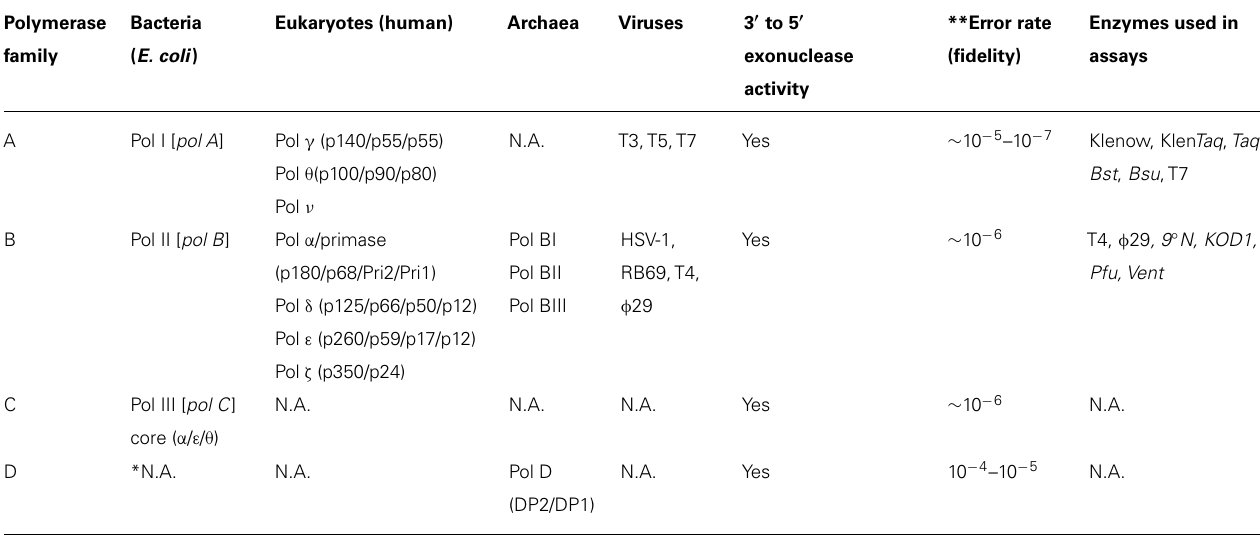
Table 1 | Families and properties of cellular DNA replicases (Kunkel, 2004; Hübscher etal., 2010; Greenough etal., 2014).